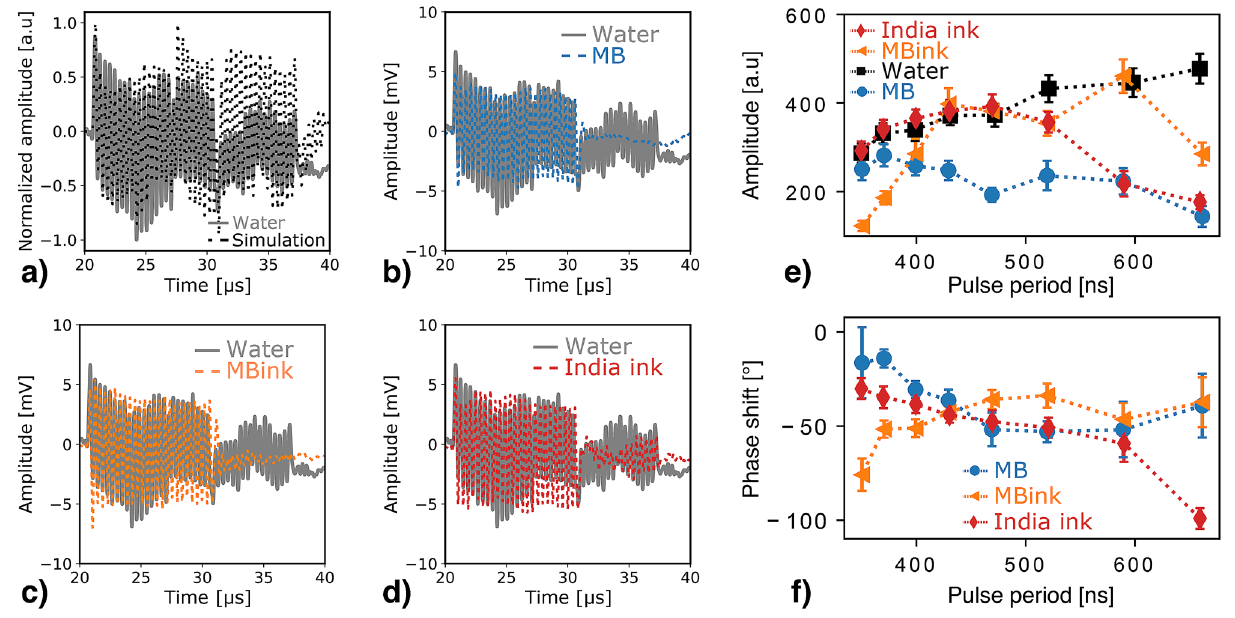
Figure 3. Evolution of the ionoacoustic signals with the pulsing period of the mono-energetic proton beam. Measured signals for a 25-cycle proton pulse of 400 ns period in water (gray) compared to ( a ) simulated signal in water (black dashed line), with ( b ) SonoVue microbubbles (blue), ( c ) SonoVue microbubbles / India ink mixture (orange), ( d ) India ink alone (red). All the experimental measurements have been averaged over 3000 acquisitions. ( e ) Evolution of the signal amplitude with the pulse period. The amplitude was extracted from the Fourier transform signals at the temporal excitation frequency to disentangle the high and low frequency components of the signal. ( f ) Phase shift as a function of the pulsing period between the signals measured in water and with CA. All the experimental measurements have been averaged over 3000 acquisitions and filtered using PyWavelets Python package. All error bars correspond to measurement uncertainties obtained from 30 consecutive measurements and given with a confidence level of